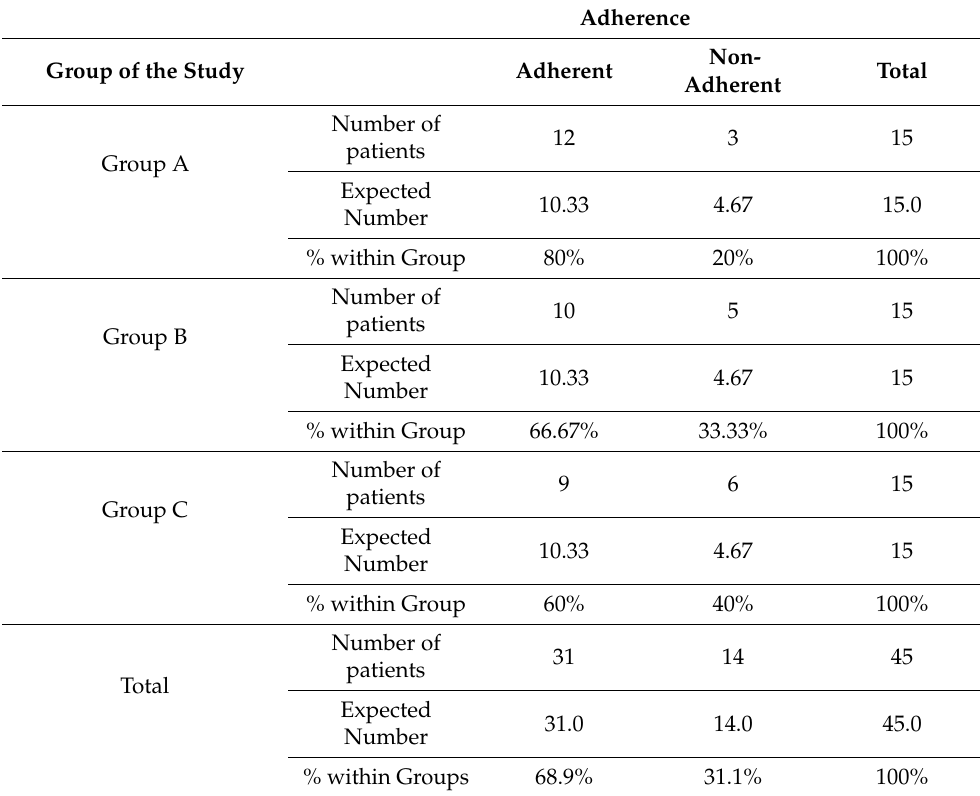
Table 4. The relationship between the groups and the level of adherence.